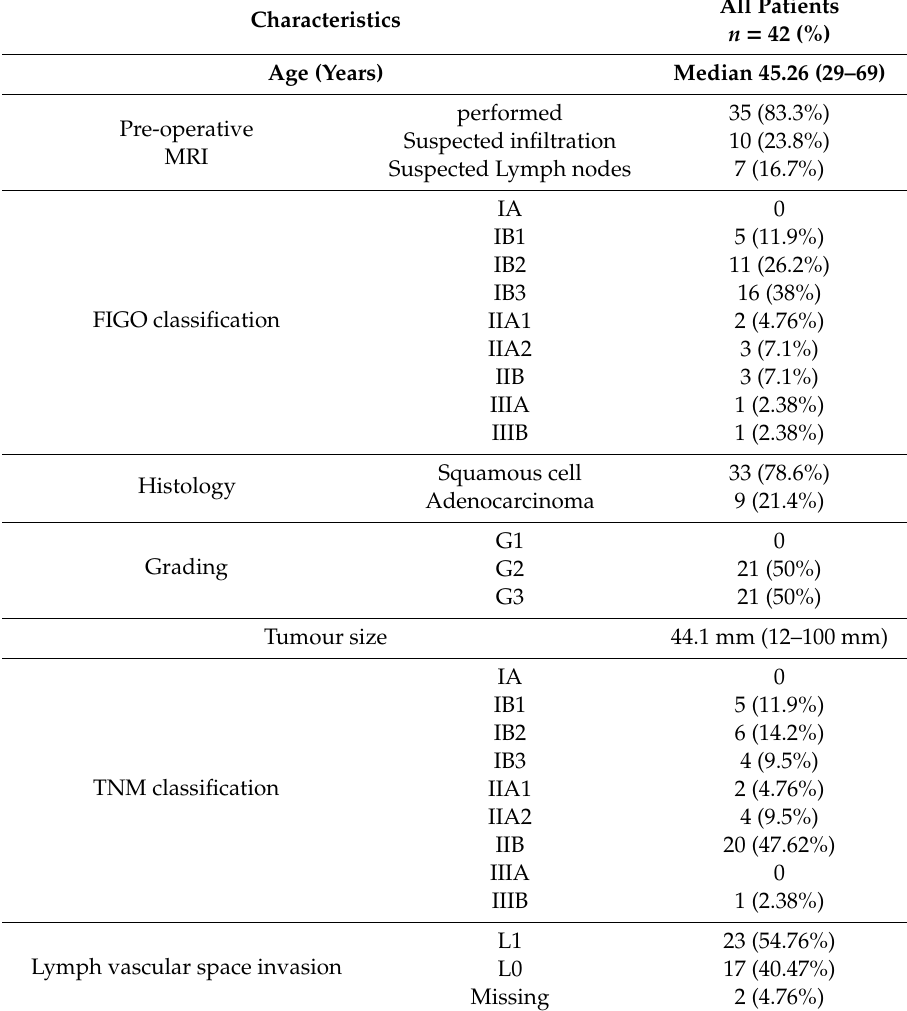
Table 1. Patient and tumor